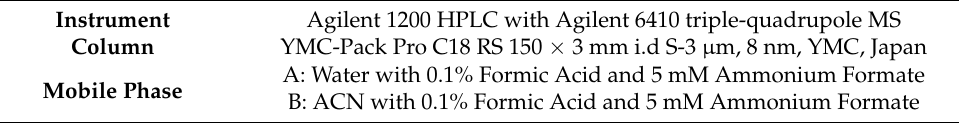
Table 2. LC–MS/MS conditions for quantitative analysis of the reduction rate of plasma treated